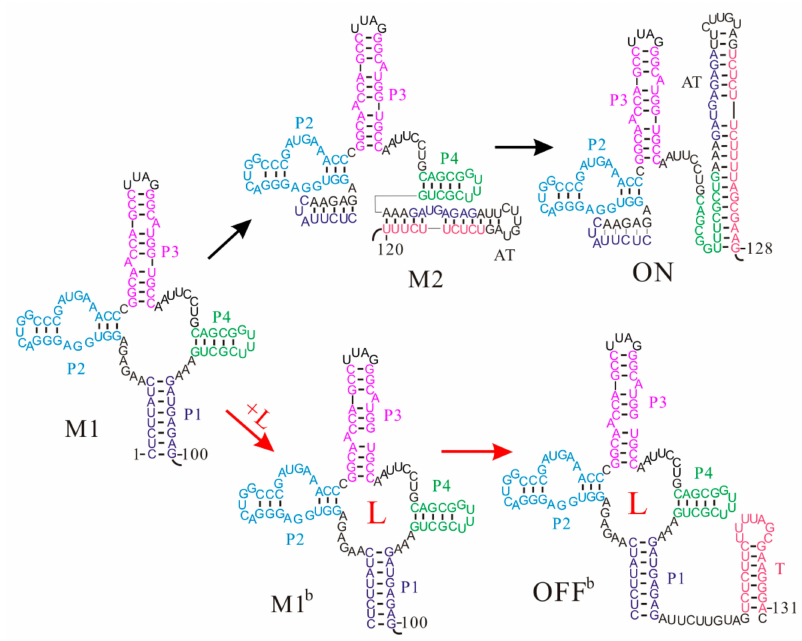
Figure 3. The main co-transcriptional folding pathways of the metF S-box riboswitch. Helices P1, P2, P3, and P4 and the T hairpin are colored differently. AT is the anti-terminator hairpin; L is the ligand S-adenosylmethionine